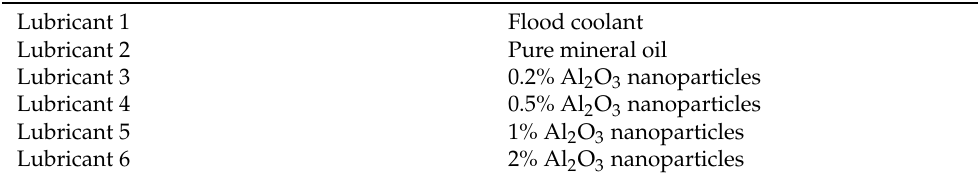
Table 6. Lubricant types used in this